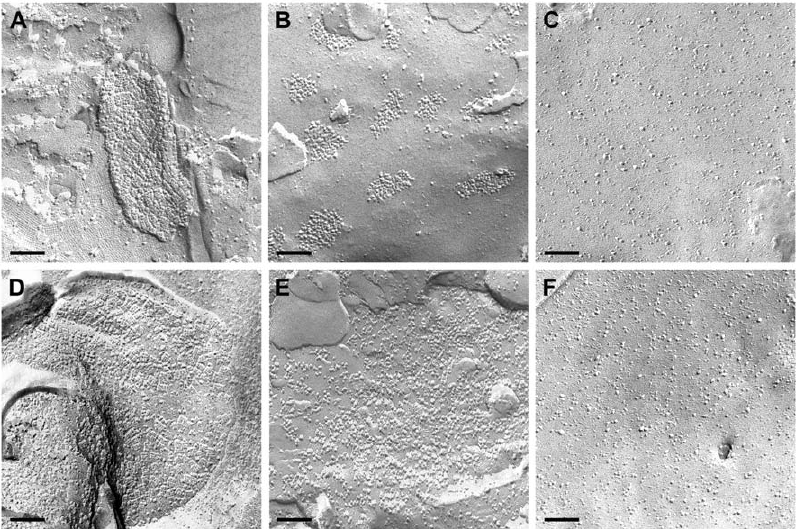
Figure 5. Freeze fracture analysis. (A) Normal human brain tissue and rat brain tissue (D) showing astrocytic endfoot membranes studded with OAPs containing AQP4. (B) Altered morphology of clustered OAPs in human glioblastoma tissue. (C) Primary cell culture membranes of human glioblastoma are devoid of OAPs as well as intracerebral RG-2 tumor (E), and the RG-2 cell line (F). Scale bars 100 nm.